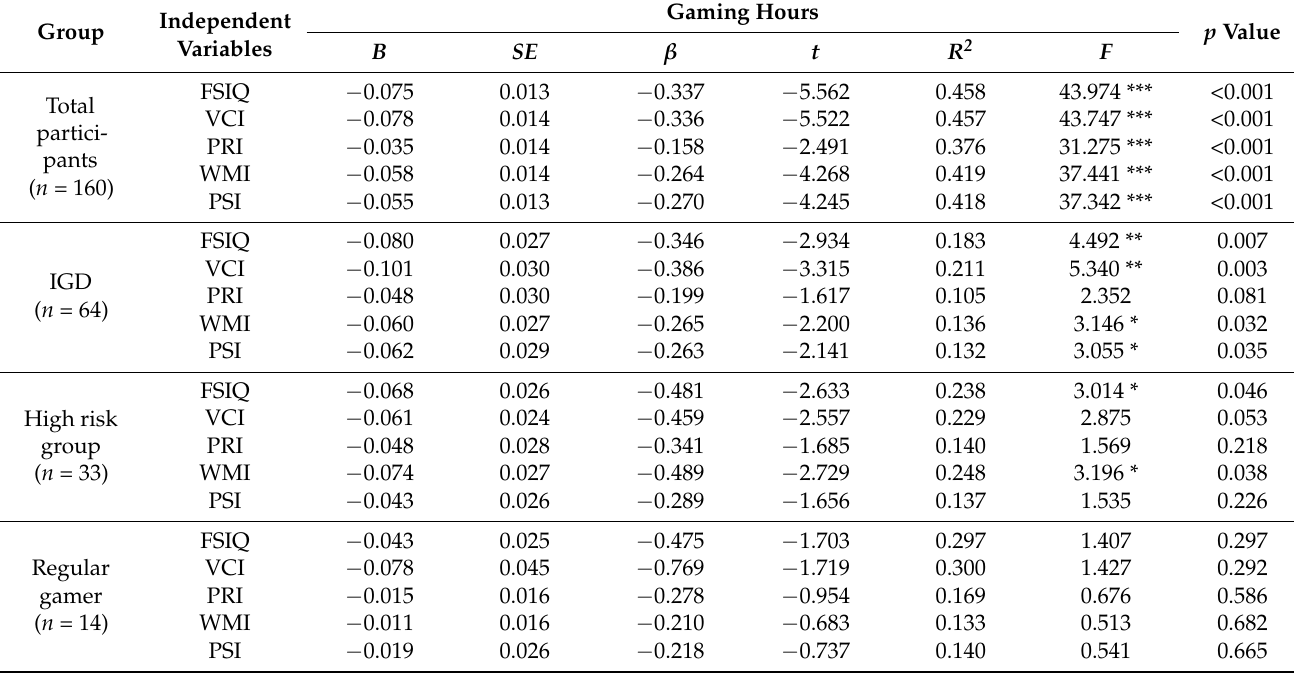
Table 6. Simple linear regression of intelligence index on gaming